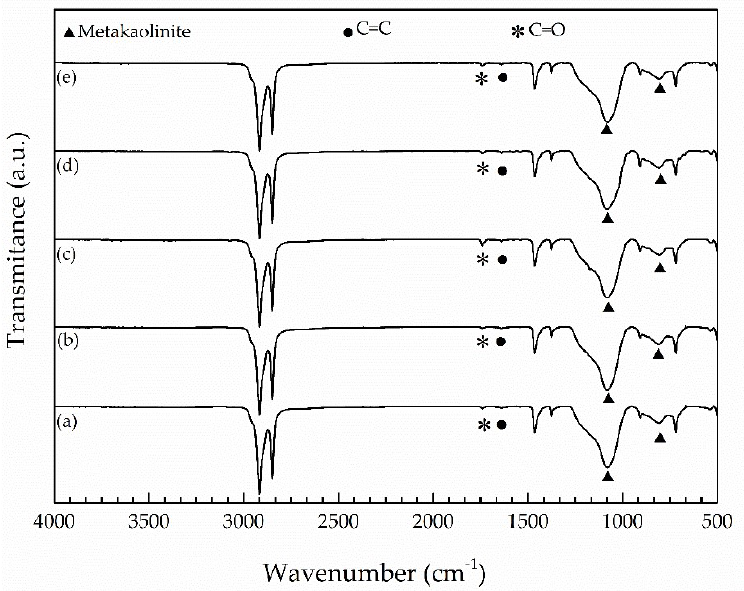
Figure 1. FTIR spectra of the insulation layer of cables ( a ) A; ( b ) B; ( c ) C; ( d ) D and ( e ) E. ▲ stands for metakaolinite, ● stands for C=C and * stands for C=O bands.